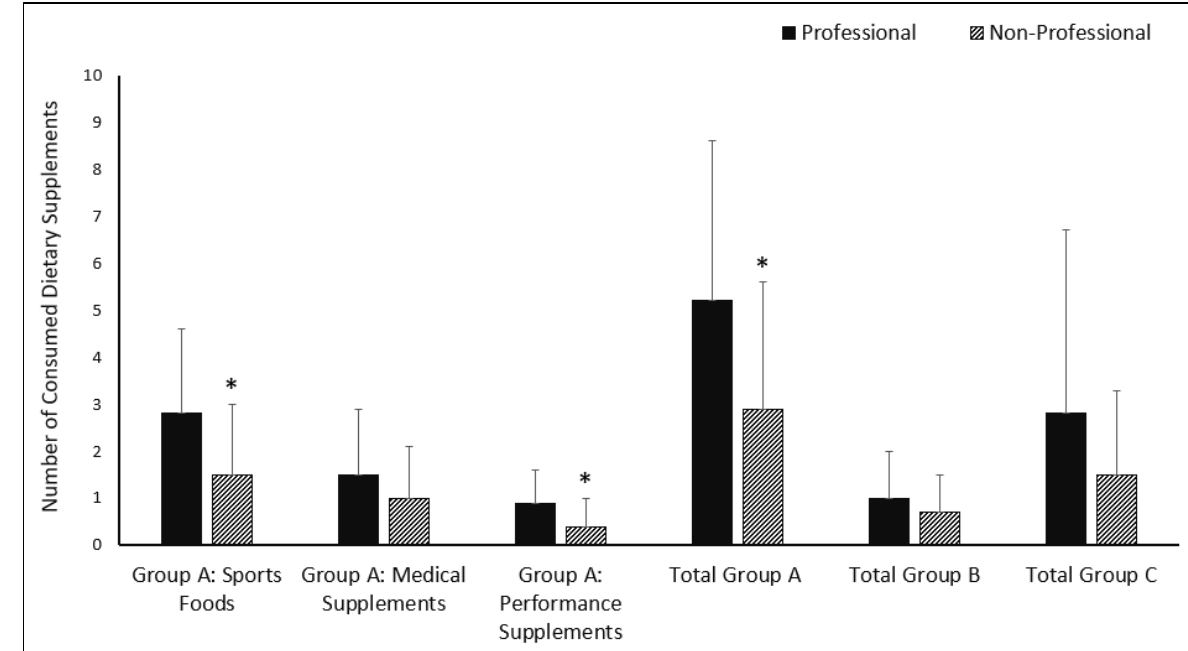
Figure 2. DS consumption in Turkish footballers by competition level according to AIS classification [12]. * Statistical differences between professional and non-professional ( p < 0.05). Table 2. DS most consumed by sex according to AIS classification